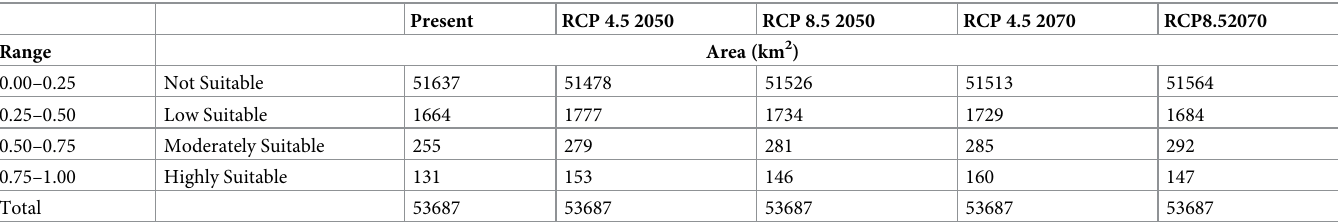
Table 2. Predicted habitat suitability area (km 2 ) of D . hatagirea , in the present and future climate change scenarios (RCP 4.5–8.5; 2050 and